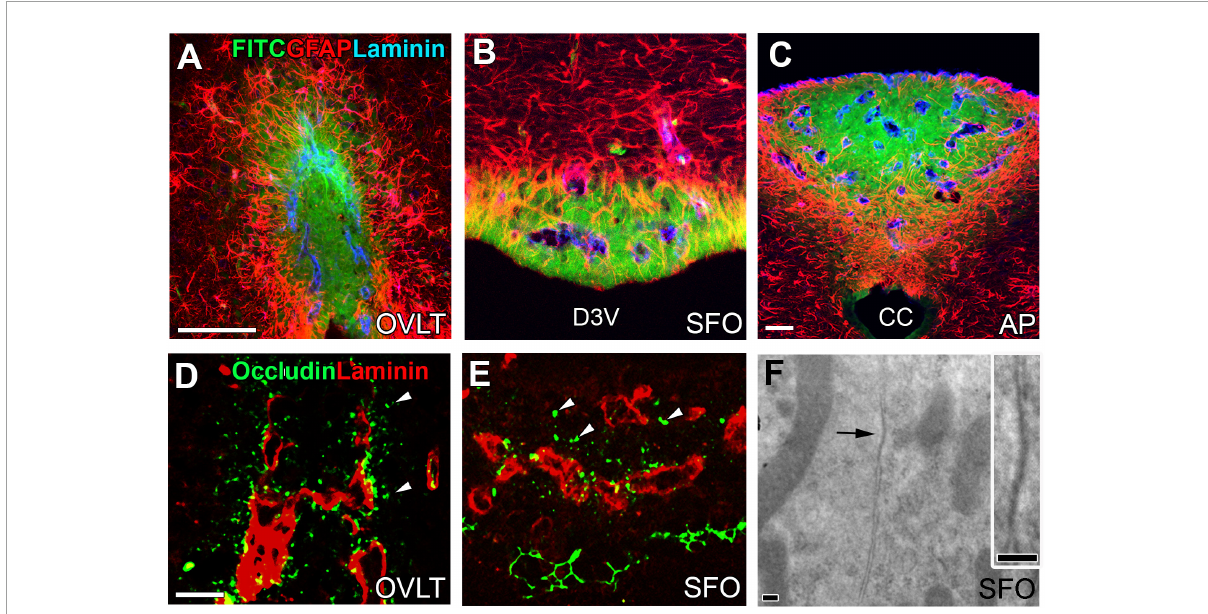
FIGURE2 Vascular permeability and tight junctions in the CVOs of the adult mouse brain. Strong fluorescence of blood-derived fluorescein isothiocyanate is seen at the central subdivision of the sensory CVOs, but fluorescence is weak at distal subdivisions and no fluorescence is seen in the neighboring brain region beyond dense astrocytic and tanycytic barriers (A–C) . Tight junction protein occludin is seen at parenchyma close to fenestrated capillaries and tanycytic layers (D,E) . An electron microscopic image reveals the tight junction-like structure between the plasma membrane of neighboring cells making complete contact (F) . Scale bar = 50 µ m (A,C,D) and 100 nm (F) . AP, area postrema; CC, central canal; D3V, dorsal 3rd ventricle; FITC, fluorescein isothiocyanate; GFAP, glial fibrillar acidic protein; OVLT, organum vasculosum of the lamina terminalis; SFO, subfornical organ. Photographs are rearranged with permission from Springer Nature (Morita et al.,